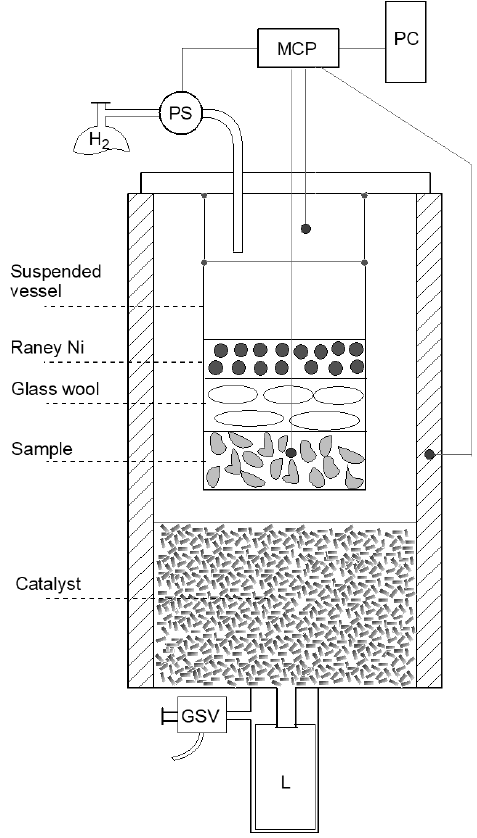
Figure 1. Pressure reactor. Outer part (500 cm 3 ) is filled with catalyst and fitted with gas-sampling valve (GSV) and a cooled, calibrated glass vessel at the bottom of the reactor (L) for liquid product collection. Inner part (90 cm 3 ) is suspended inside the outer reactor part and contains the sample and Raney nickel layer. PS—pressure sensor, MCP—measuring control panel; hatched areas—electric vertical oven; black dots: thermocouple for measuring the temperature in the center of the sample, control thermocouple and thermocouple measuring the gas temperature.